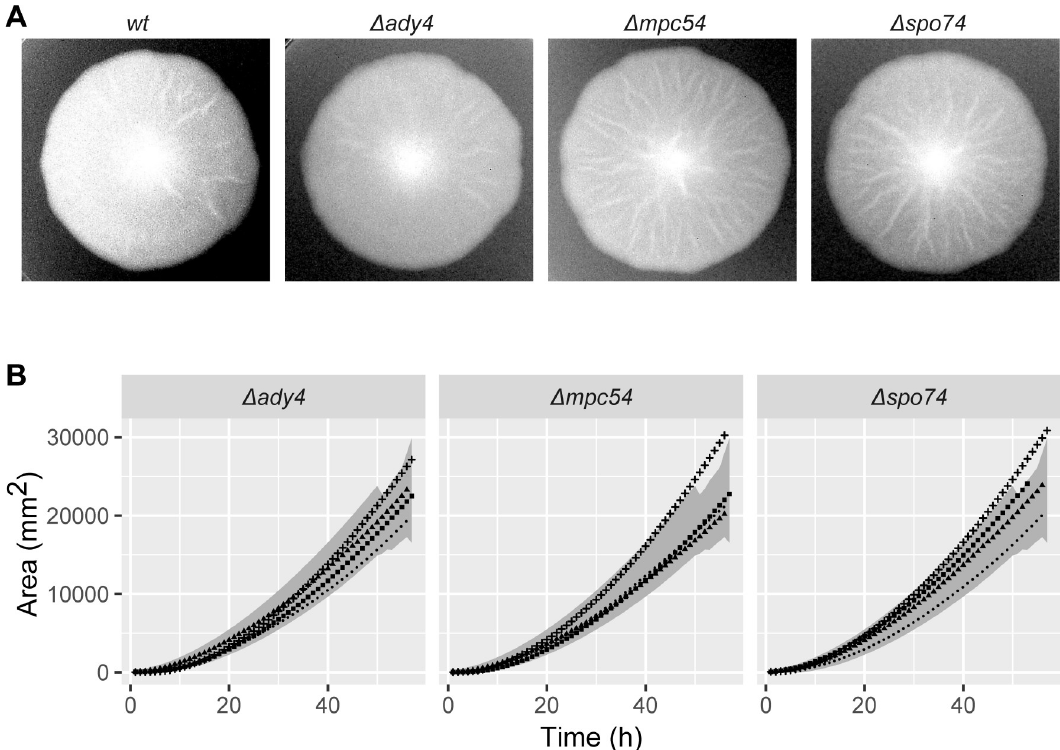
Fig 5. Radial growth of strains carrying deletions of SOP-components. A) Sample images of mycelia grown for 4 days. B) The graph represents the area of the mycelium growing (in mm 2 ) measured every 3 hours over the indicated time frame.